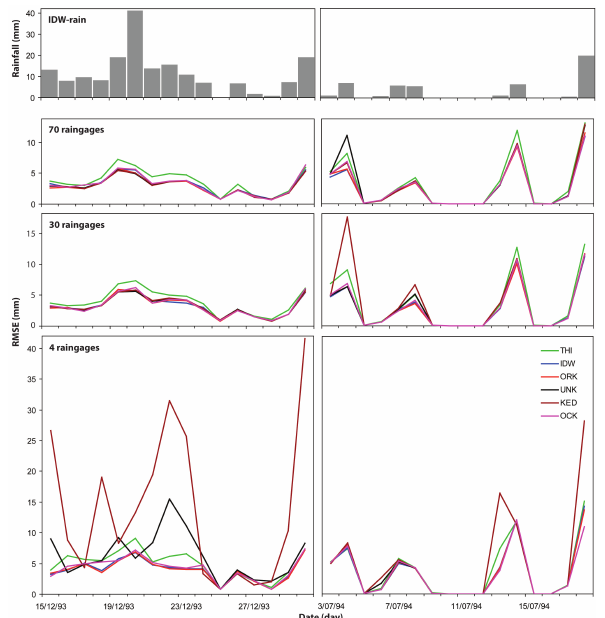
Fig. 11. Cross validation of different interpolation methods for a period of winter (left) and a period of summer (right). The first graph presents the areal rainfall interpolated by IDW; the second graph present the daily RMSE of the methods made using 70 rain- gages; the third graph present the daily RMSE of the methods made using 30 raingages; the fourth graph present the daily RMSE of the methods made using 4 raingages.